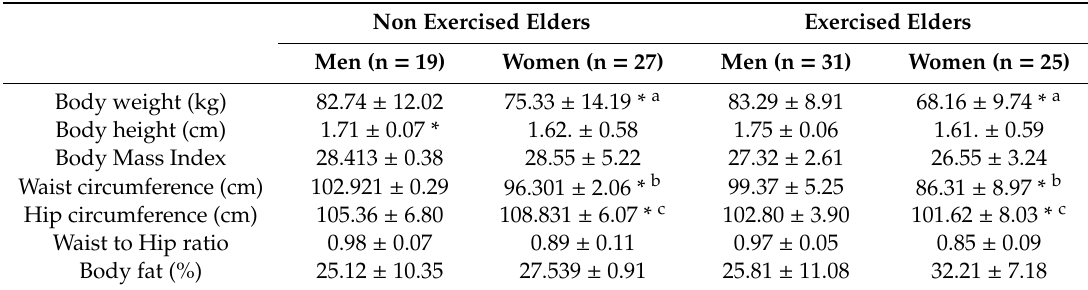
Table 4. Anthropometric characteristics according to gender and exercise. Non Exercised Elders Exercised Elders